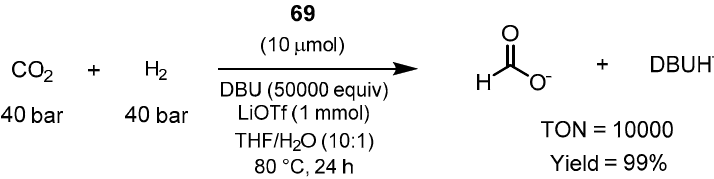
Figure 6. Ru-NNN pincer complexes synthetized and characterized by Peng and Zhang [648].